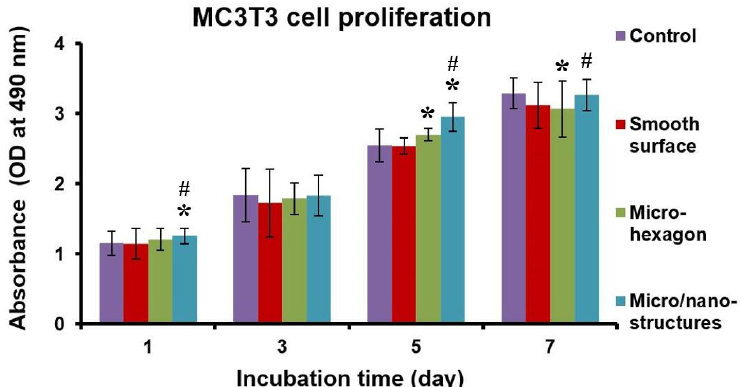
Figure 5. The effect of Ti-6Al-4V samples with a smooth surface, micro-hexagons and composite micro/nano-structures on cell viability evaluation using CCK-8 array (optical density, OD) at various days (1, 3, 5, 7 day) of culture. * refers to a statistically significant p value below 0.05 vs. control; # refers to a statistically significant p value below 0.05 vs. smooth surface.